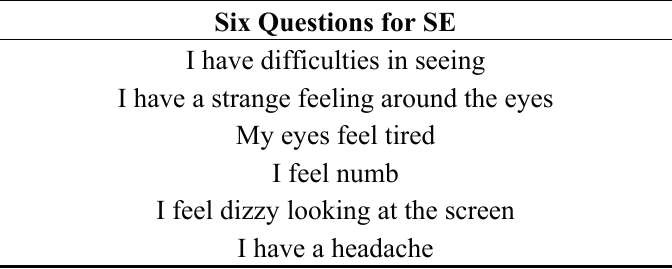
Table 2. Items in questionnaire form for SE.